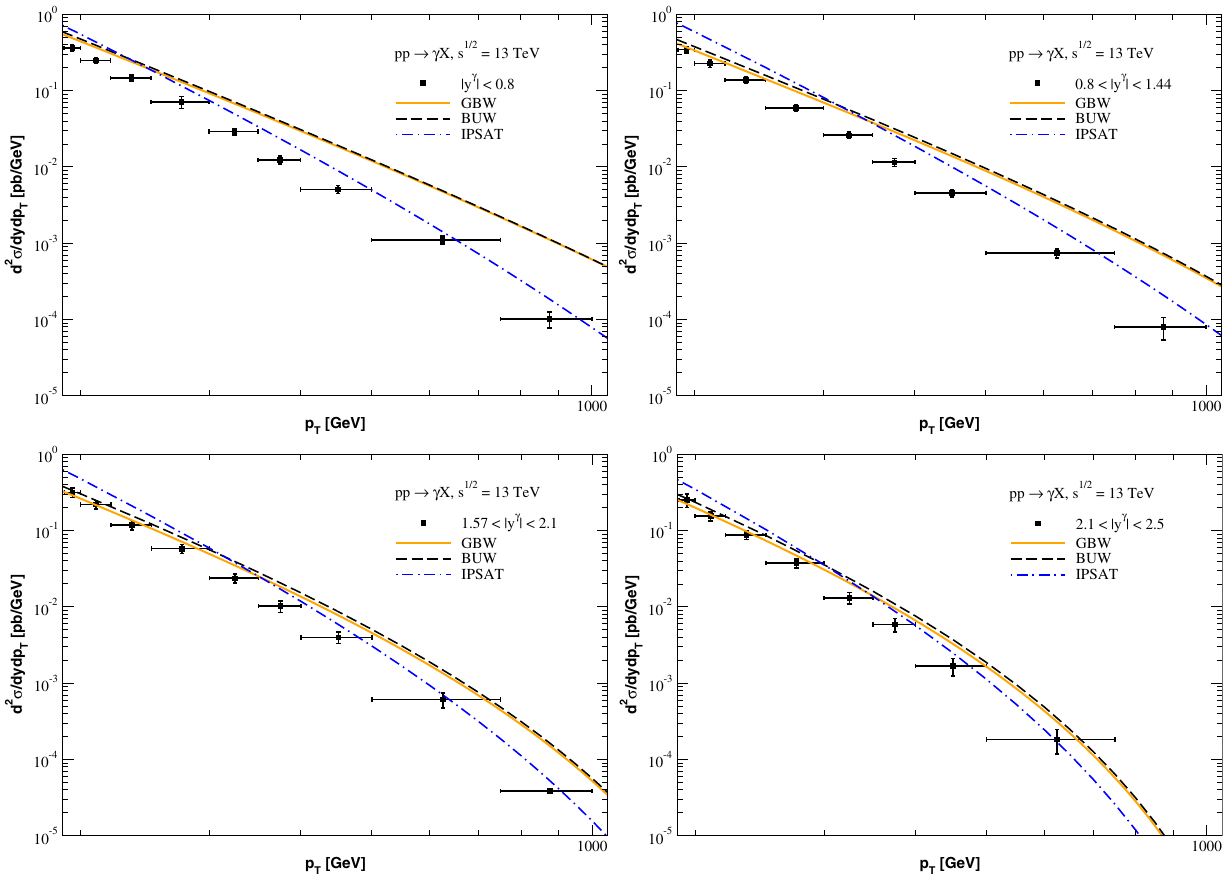
√ s = 13 TeV and considering four rapidity bins. The predictions